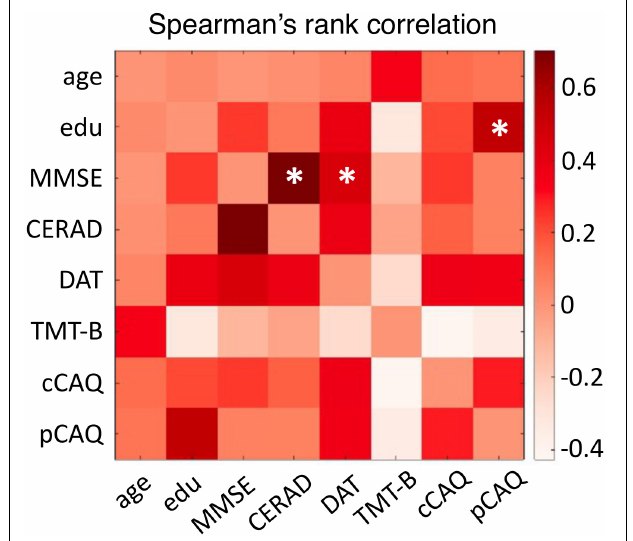
FIGURE 1 | Relationships between cognitive and cognitive reserve scores. The matrix entries represent the Spearman’s rank correlation coefficient between cognitive performances, cognitive reserve, age and education level. Correlations surviving multiple comparison correction ( FDR < 0.05) are indicated with an asterisk. Edu, education level; MMSE, Mini-Mental State Examination; CERAD, total score of the Consortium to Establish Registry for Alzheimer’s Disease; DAT, letters D-A-T fluency test; TMT-B, Trail Making Tests B score; cCAQ, current engagement in cognitively demanding activities; pCAQ, past engagement in cognitively demanding activities.